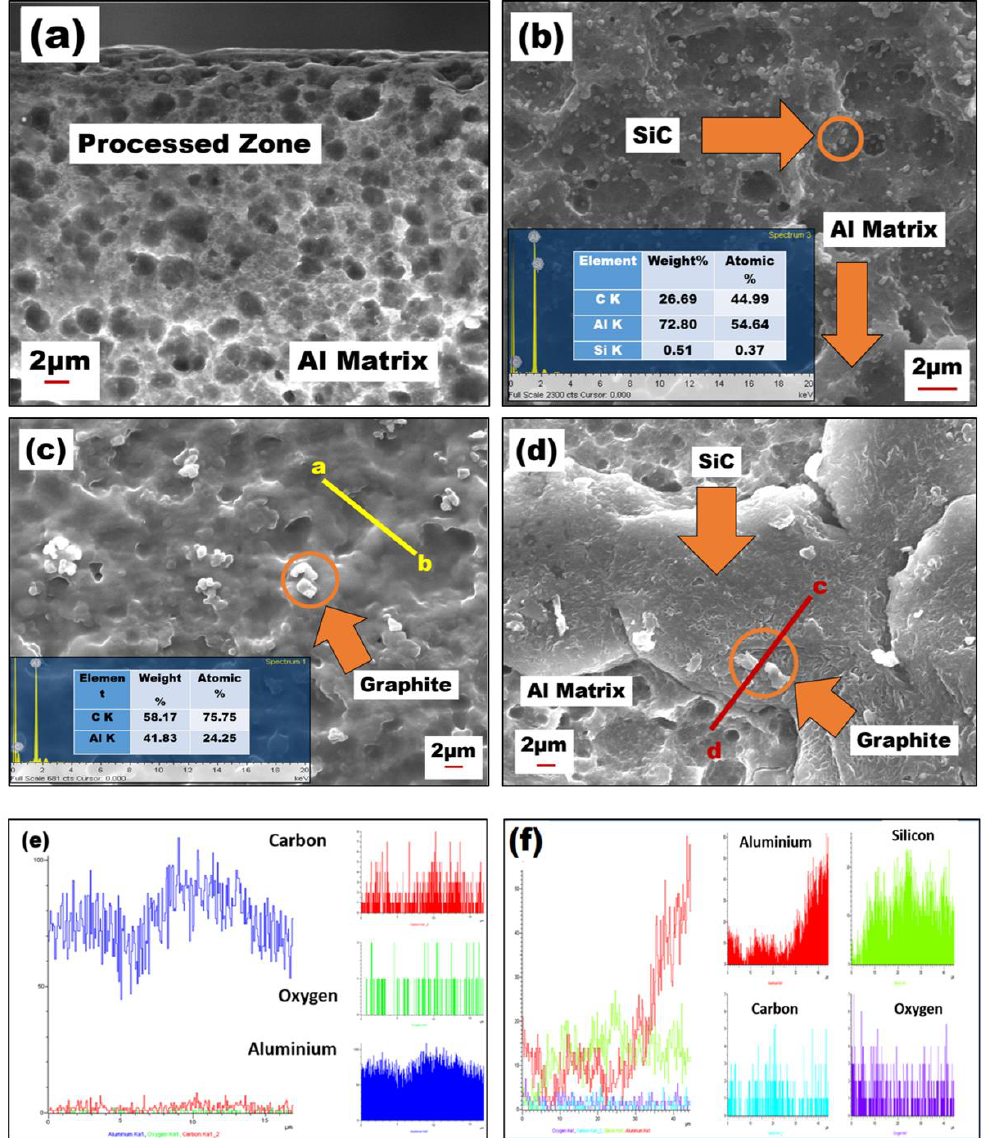
Figure 7. SEM micrographs of ( a ) processed Al, ( b ) Al-SiC mono composite, ( c ) Al-graphite mono composite, ( d ) Al-SiC-graphite hybrid composite, ( e ) line energy dispersive X-ray spectroscopy (EDX) analysis of a-b, ( f ) line EDX analysis of c-d.